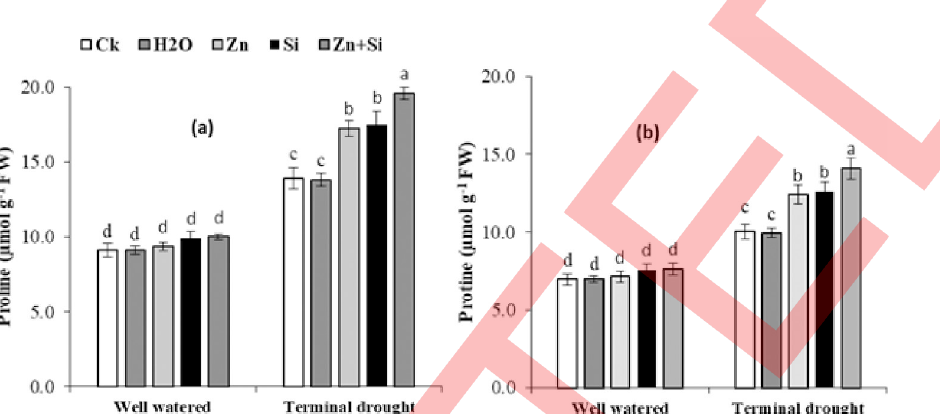
Fig 3. Effect of individual and combined application of Zn and Si on proline (a) and protein contents (b) wheat under terminal drought stress. Every column in each graph represents the mean ( ± SE) of three replicates. Zn = zinc, Si =